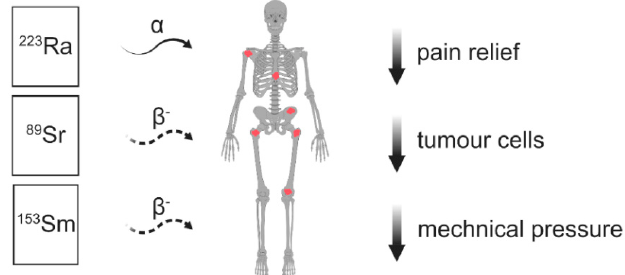
Figure 4. Usage of radioactive isotopes for multiple bone metastases. Abbreviations: 223 Ra—Radium-